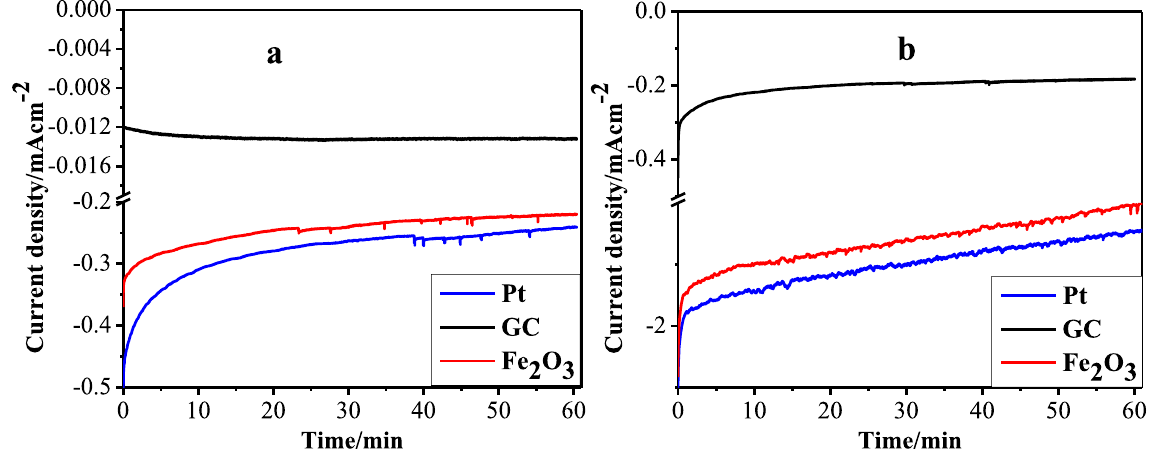
Fig. 4 V-t curves measured using different counter electrodes at; a − 0.4 V, and b − 0.6 V versus